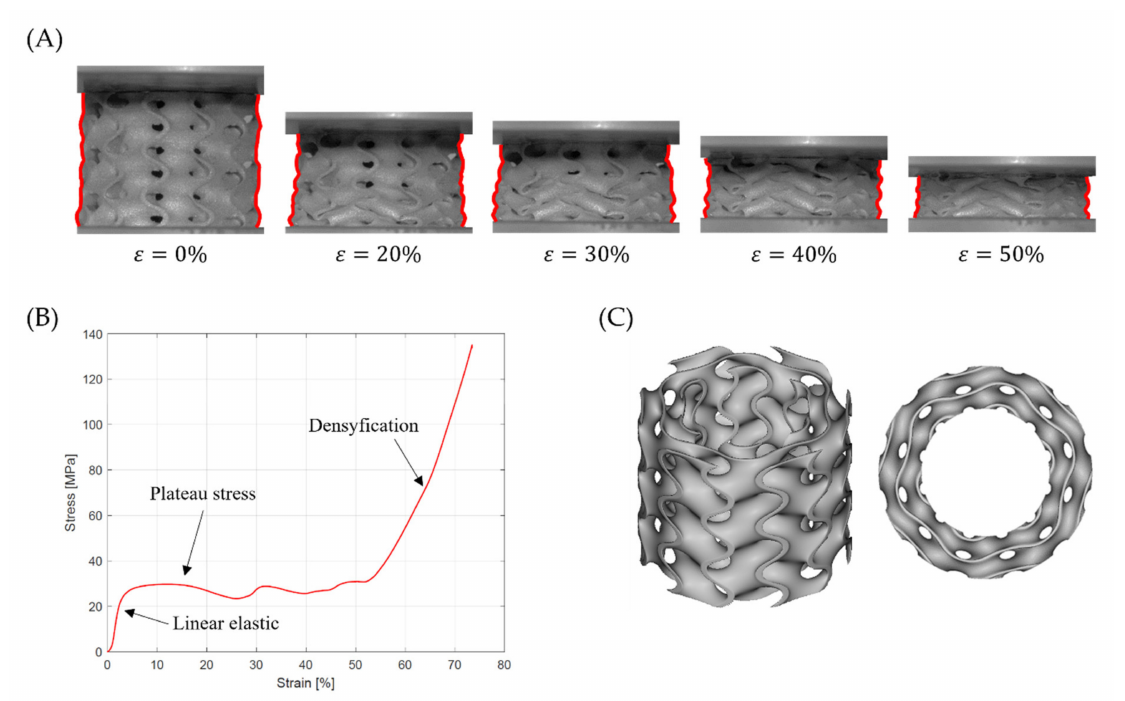
Figure 15. “Layer-by-layer” deformation mode with complete densification of collapsing layers on the example of Gyroid_6_1_20_0.87 samples: ( A ) deformation stages in the presence of 0%, 20%, 30%, 40%, 50% strain recorded by ARAMIS measurement system; ( B ) compressive stress–strain curve; ( C ) CAD project.